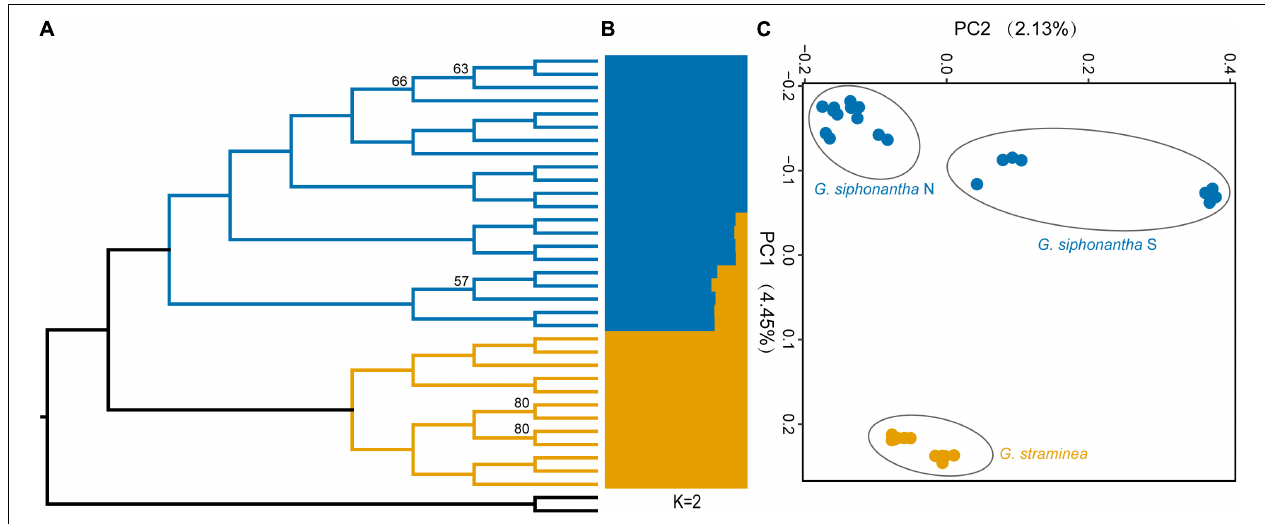
FIGURE 2 | Phylogenetic and population genetic analyses of Gentiana siphonantha and G. straminea based on SNPs. (A) Maximum likelihood- based phylogenetic analysis of the populations of G. siphonantha and G. straminea. (B) Population structure plots with K = 2 . (C) Principal component analysis plot of the first two components.